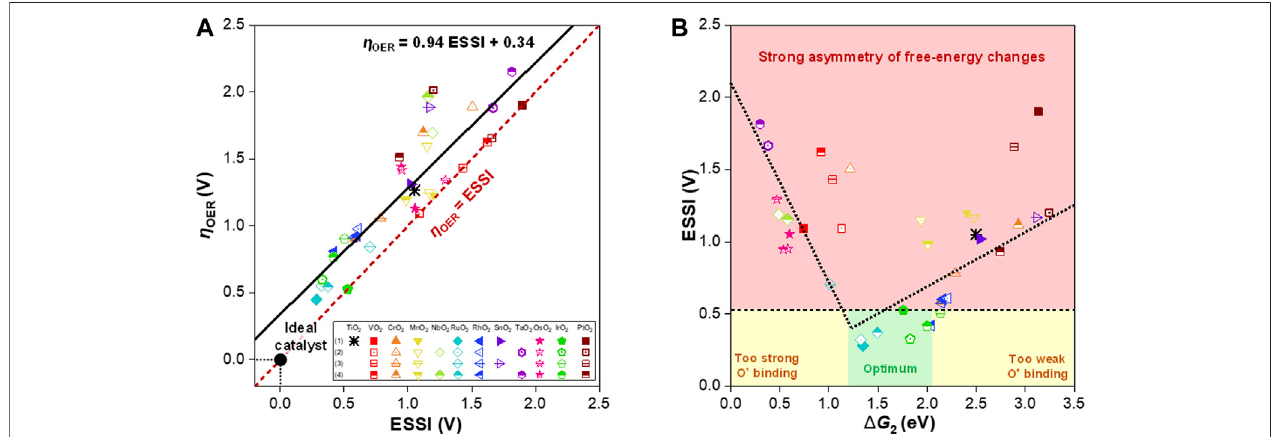
FIGURE 4 | (A) η OER asa function of the ESSI. Black solid line indicates the linear relation between η OER and ESSI. Red dotted line indicates the guideline of η OER (cid:1) ESSI. (B) ESSI- Δ G 2 activity map. Three regions are classi fi ed depending on the OER activity — green area of 1.2 eV < Δ G 2 < 2.06 eV with ESSI < 0.53 V; yellow area of Δ G < 1.2 eV or Δ G > 2.06 eV with ESSI < 0. 53 V; and red area of ESSI > 0.53 2 2